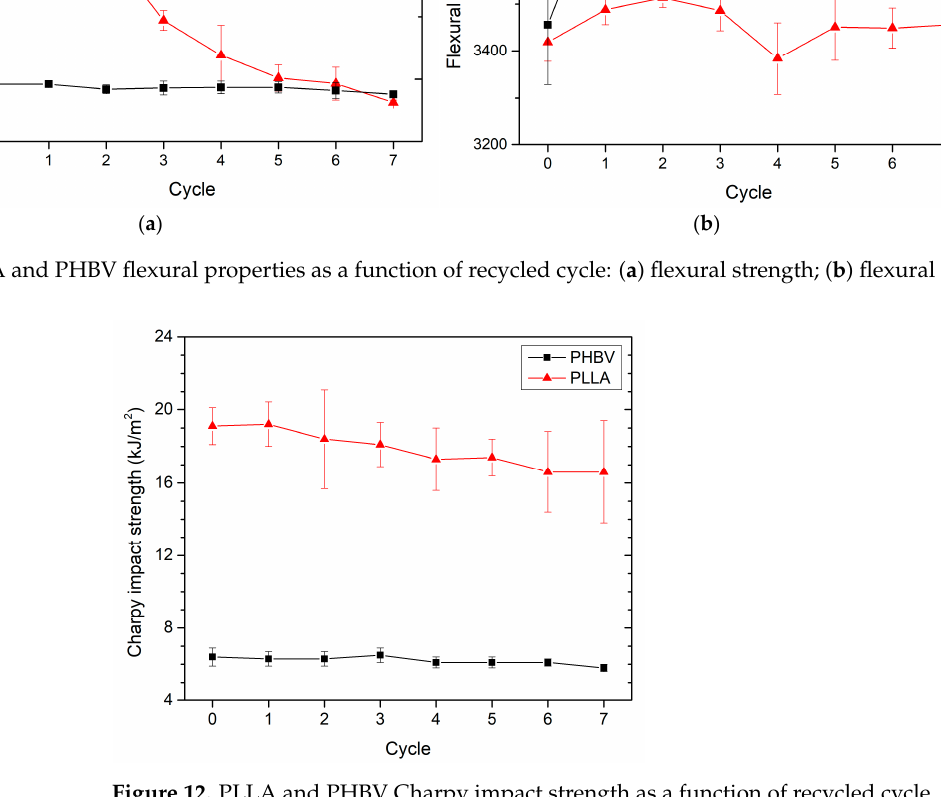
Figure 12. PLLA and PHBV Charpy impact strength as a function of recycled cycle.